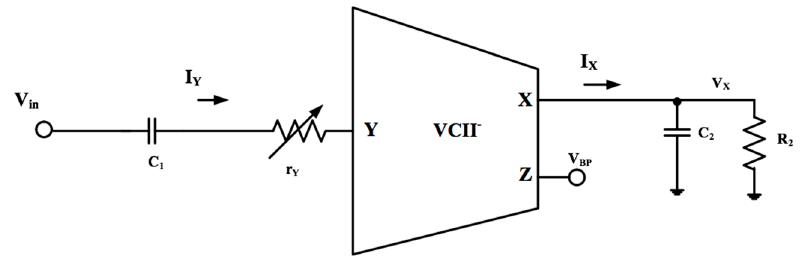
Figure 3. The proposed VCII − -based second-order BP filter realization.